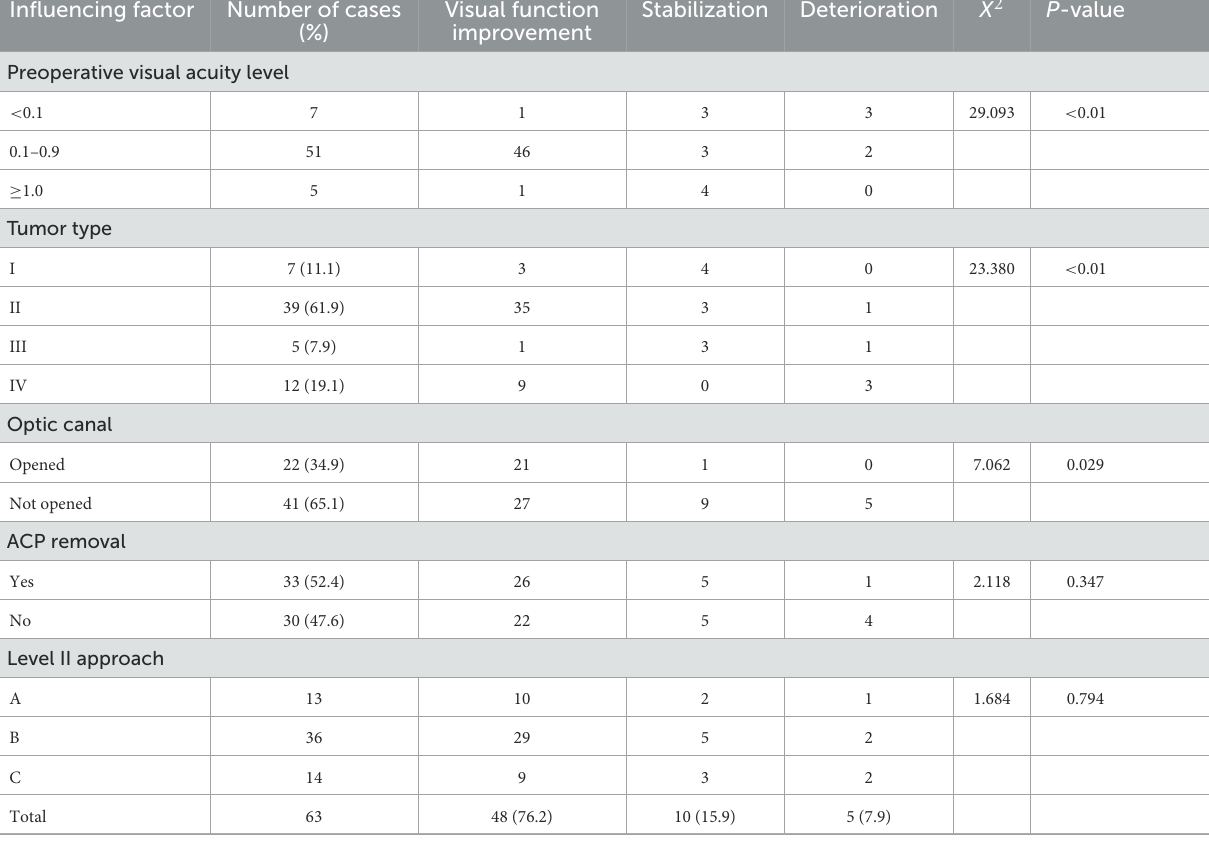
TABLE 5 Analysis of factors influencing postoperative visual function (cases). Influencing factor Number of cases Visual function Stabilization Deterioration X 2 P -value (%) improvement Preoperative visual acuity level